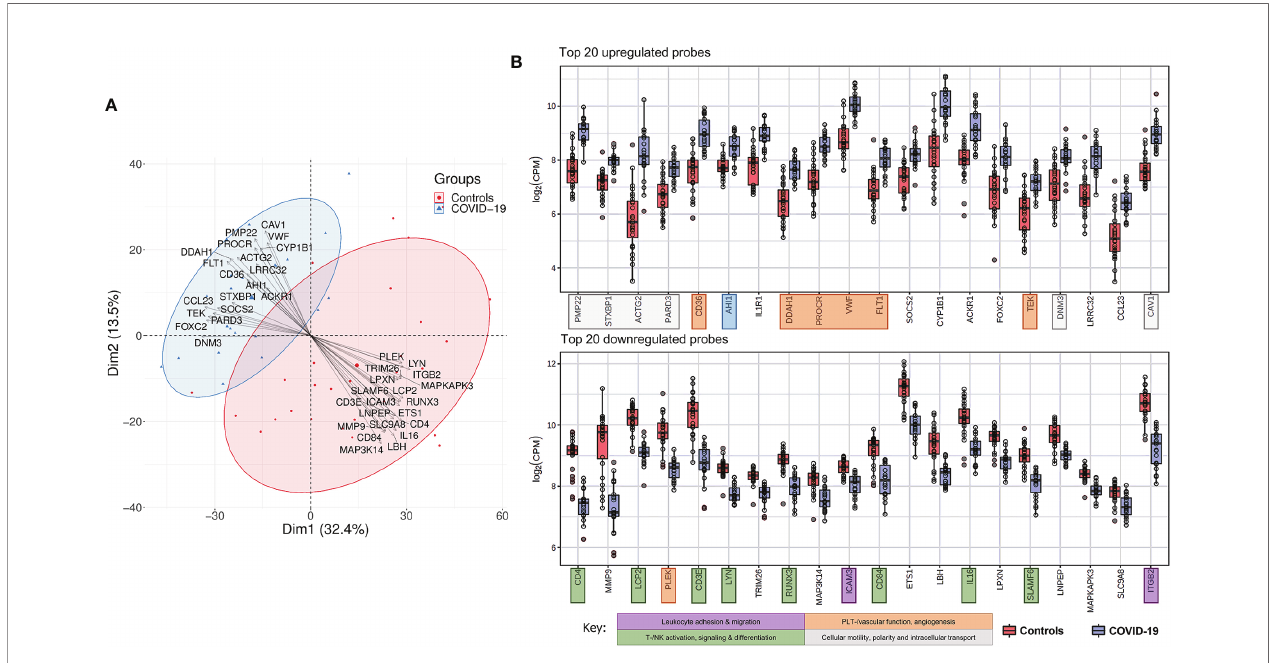
FIGURE 4 | Characteristic Gene Expression Pro fi ling of COVID-19 Lymph Nodes. (A) Principal component analysis biplot showing distinct clustering of COVID-19 and controls in whole tissue analysis. Top up- and downregulated genes are superimposed as vectors determining the individual clusters. (B) Top 20 up-regulated genes in COVID-19 versus controls: genes related to cellular structure, motility and intracellular transport, proangiogenic and prothrombotic genes were predominantly upregulated in COVID-19. Genes involved in T-/NK- and B-cell differentiation and signaling and leukocyte traf fi cking were predominantly down- regulated in